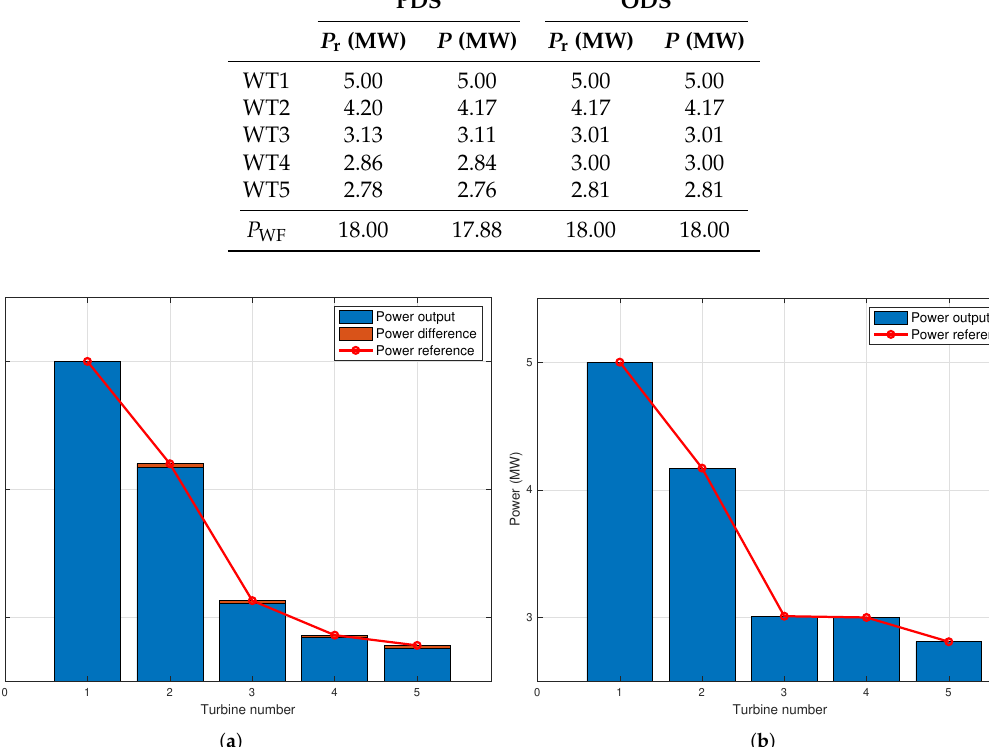
Figure 11. Comparison of power generation capacity in Case 1: ( a ) power reference and power output in PDS; ( b ) power reference and power output in